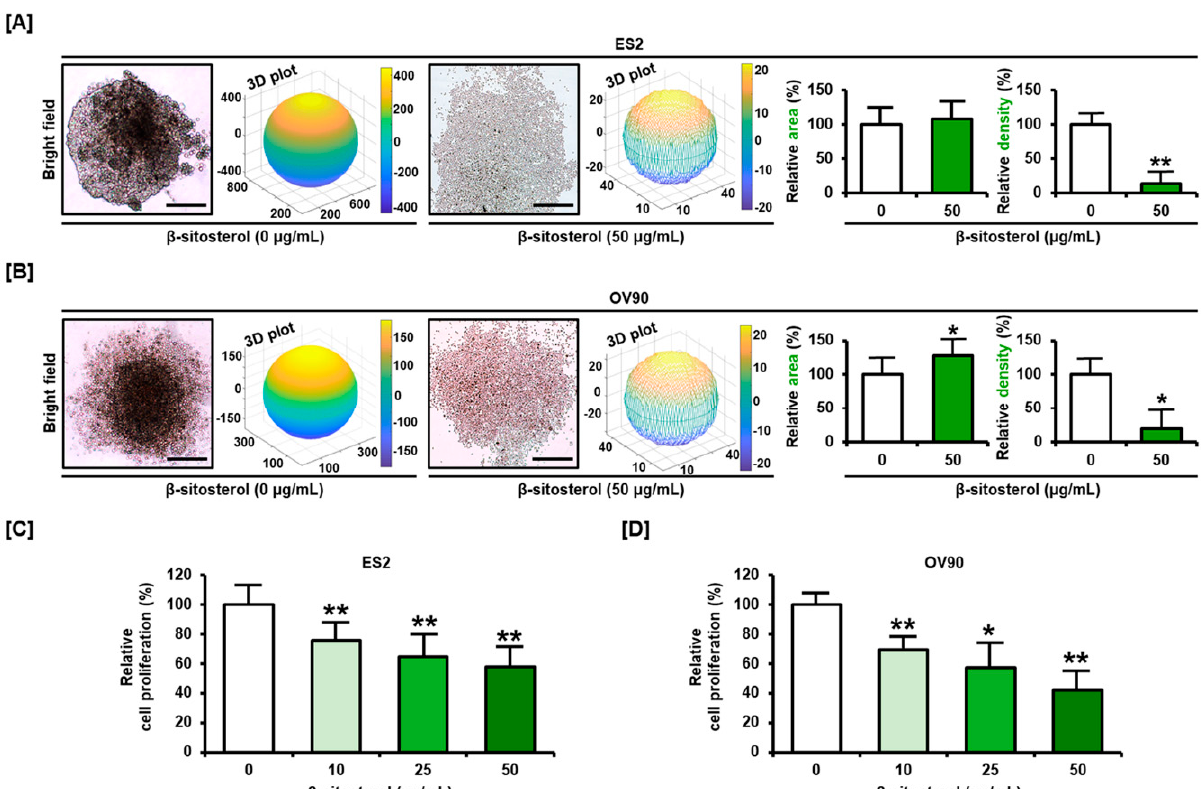
Figure 5. Restriction of cell growth by β -sitosterol in ovarian cancer cells. ( A , B ) Analysis of 3D spheroid formation by ES2 ( A ) and OV90 ( B ) cells with or without β -sitosterol. ( C , D ) Cell proliferation assay following β -sitosterol treatment (0, 10, 25, and 50 µ g/mL) for both cell lines. Comparative bar graphs represent the % of cell growth compared to the vehicle-treated control (100%) for ES2 ( C ) and OV90 cells ( D ). The asterisks indicate significant differences between treated and control cells (** p < 0.01, and * p < 0.05).